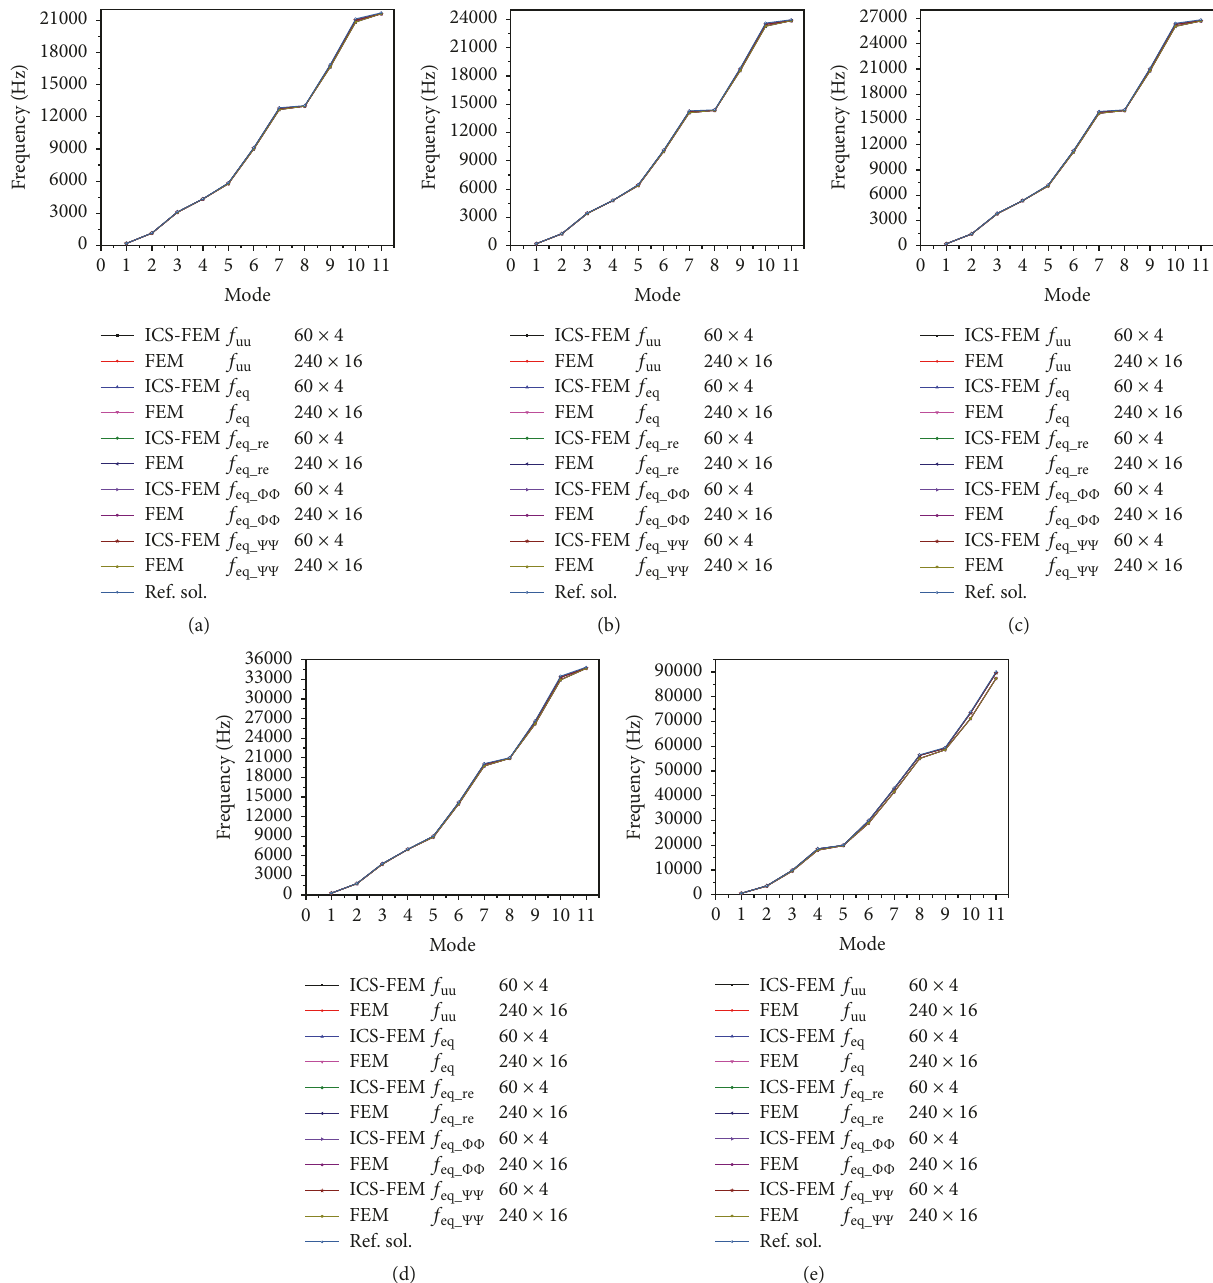
Figure 9: Structural frequencies 𝑓 of clamp-free CoFe 2 O 4 FGMEE beams with exponential factor 𝜂 = (a) 0, (b) 0.5, (c) 1.0, (d) 2.0, and (e)